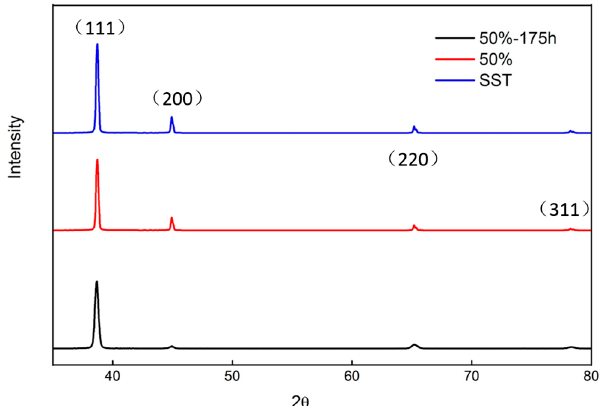
Figure 1. XRD patterns of the aluminum alloy before (SST) and after deformation treatment (50%), as well as the one after aging for 175 h (50%-175